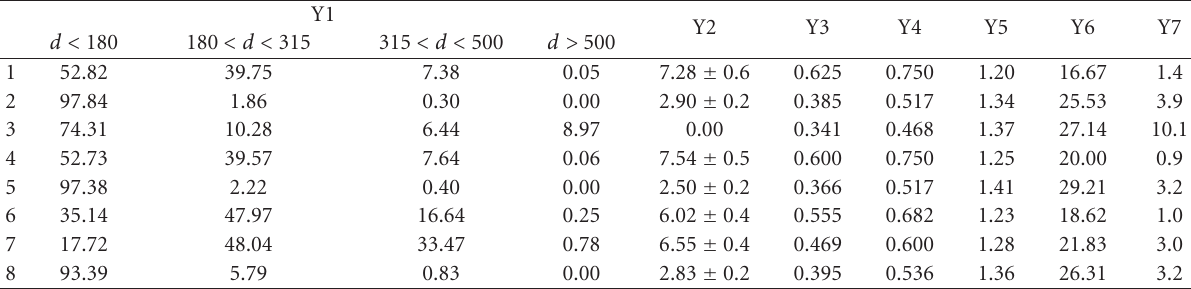
Table 5: Granules characterization.